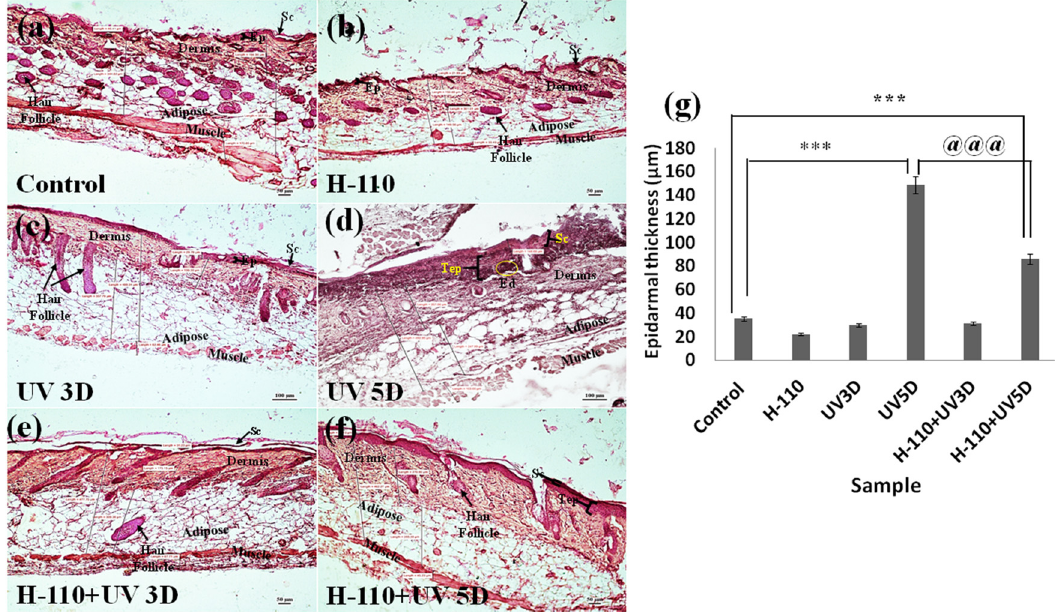
Figure 10: Transverse section showing histoarchitecture of skin tissue of M. musculus : ( a ) control, ( b ) H - 110 treated, ( c ) UVB treated for 3 days, ( d ) UVB treated for 5 days, ( e ) H - 110 + UV treated for 3 days, and ( f ) H - 110 + UV treated for 5 days; Ep represents epidermis, Sc represents stratum corneum, Tep represents thickening epidermis, and Ed represents edema. ( g ) The vertical bar represents the epidermal thickness of di ff erent treatment groups ( mean ± SEM ) . Signi fi cance was tested using one - way ANOVA followed by Tukey post - hoc test. The symbol * shows the signi fi cance level between control and only UVB 5 days, # shows the signi fi cance level between control and H - 110 + UVB 5 days, and @ shows the signi fi cance level between only UVB 5 days and H - 110 + UVB 5 days. Data were considered statistically signi fi cant as ***/###/@@@ for P <